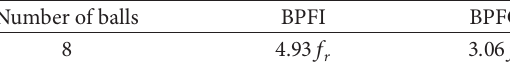
outer race) represent the fault characteristic frequency of the outer race and the inner race, respectively, and 𝑓 𝑟 is the shaft rotational frequency. The sampling frequency is set as 1024 Hz; the sampling time is 4